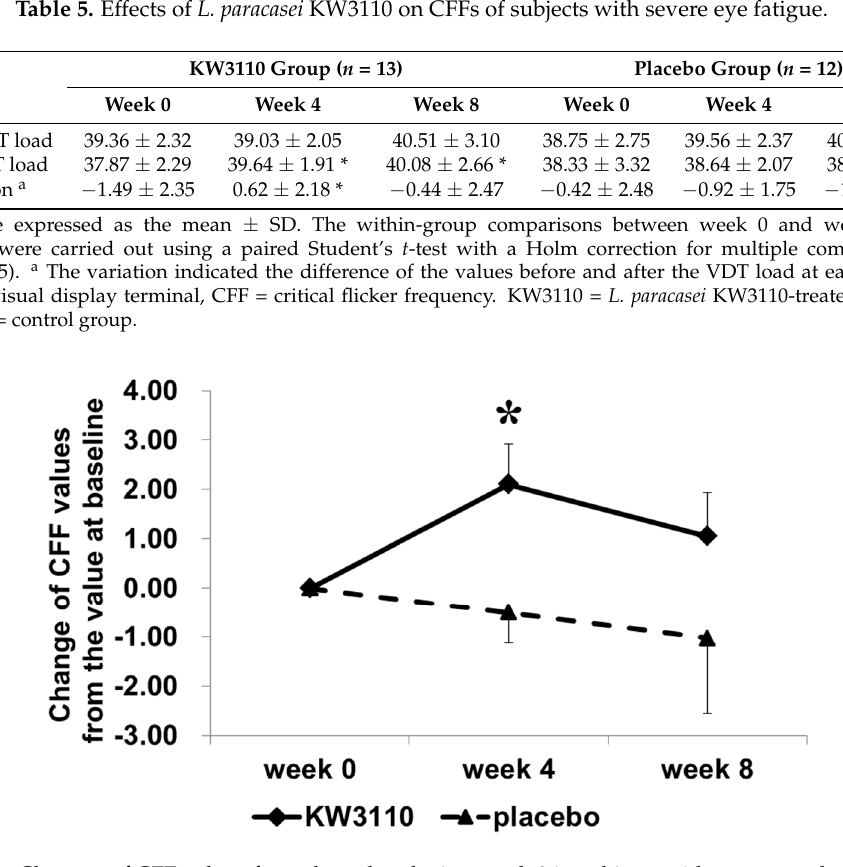
Figure 3. Changes of CFF values from the value during week 0 in subjects with severe ocular fatigue sensation before the VDT load. VDT = visual display terminal, CFF = critical flicker frequency. KW3110 = L. paracasei KW3110-treated group, placebo = control group. (* p < 0.05). Data are calculated as the degrees of change from the values during week 0. The comparisons between two groups at each time point were performed by an unpaired Student’s t -test with a Holm correction for multiple comparisons (* p < 0.05 versus placebo). Data are shown as the means ± SE. Table 6. Effects of L. paracasei KW3110 on subjective symptoms of eye fatigue and related visual conditions for subjects with severe eye